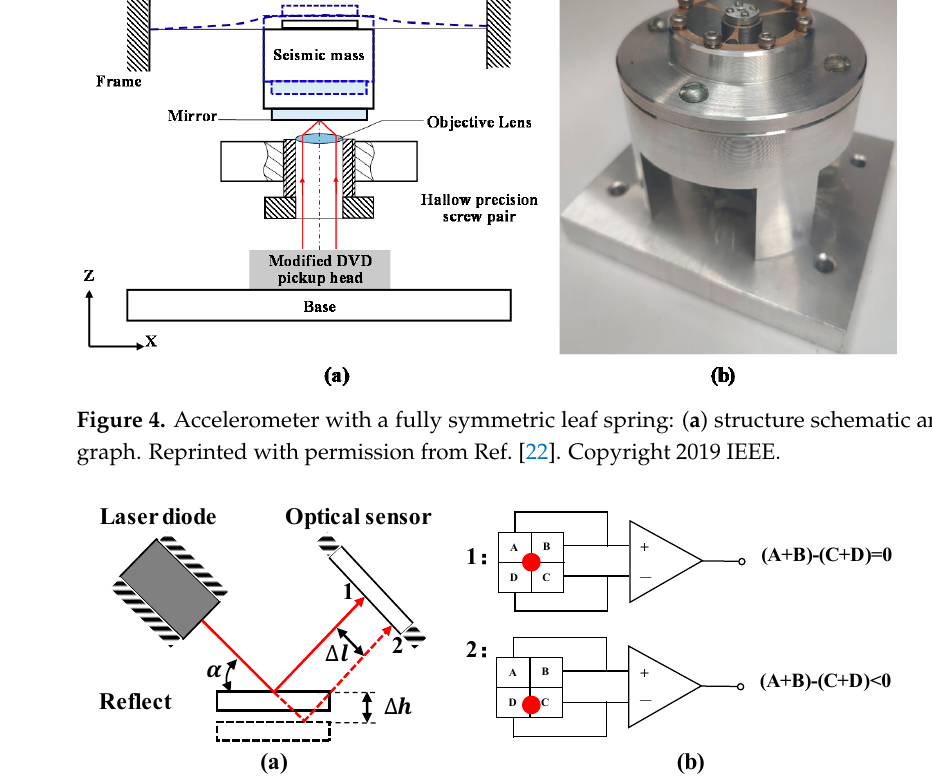
Figure 5. Principle of LTG: ( a ) optical path and ( b ) output signal.